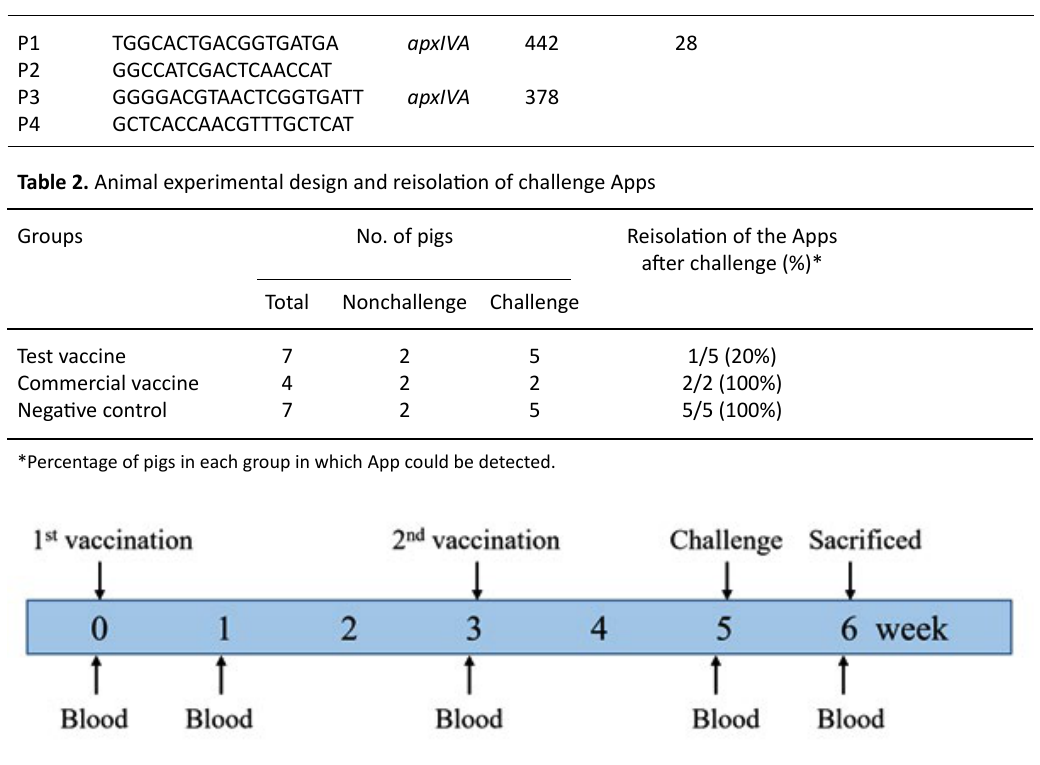
Fig. 1. Animal experimental design. Pigs were immunized with two doses of the test vaccine, the commercial vaccine, or PBS at 0 and 3 weeks, and challenged with virulent App strains at 5 weeks after the first vaccination. Blood samples were collected at 0, 1, 3, 5, and 6 weeks after the first vaccination.